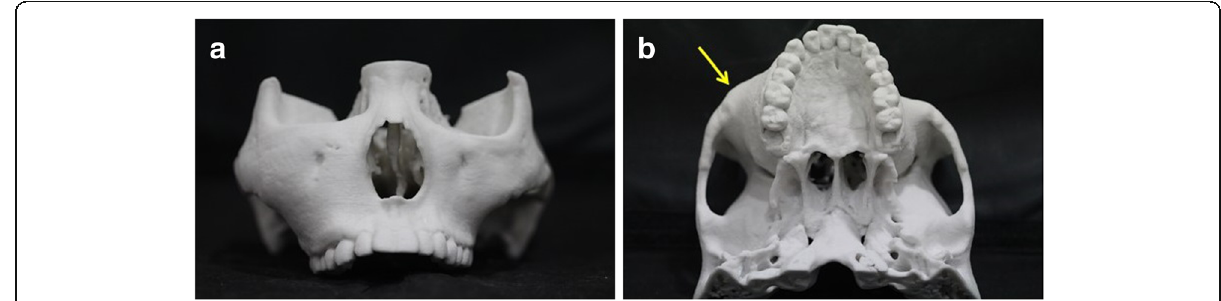
Fig. 3 Preoperative skull model. a , b Arrows indicate the location of the midfacial fibrous dysplasia lesion. The right maxilla and zygomatic body were enlarged with an asymmetric